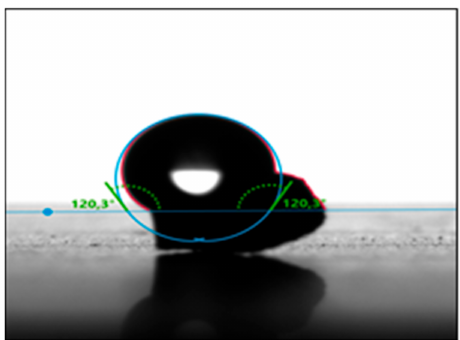
Figure 21. Rubber contact angle under the second treatment (R2), 120.3 ◦ .